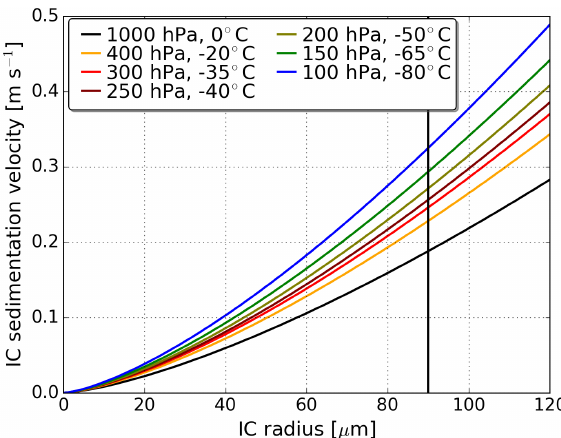
Figure 1. Ice crystal sedimentation velocities as a function of IC radius for the selected atmospherically relevant conditions in ECHAM-HAM (Spichtinger and Gierens, 2009). The black verti- cal line represents the maximum radius ice crystals can have before they are transferred to the precipitating snow